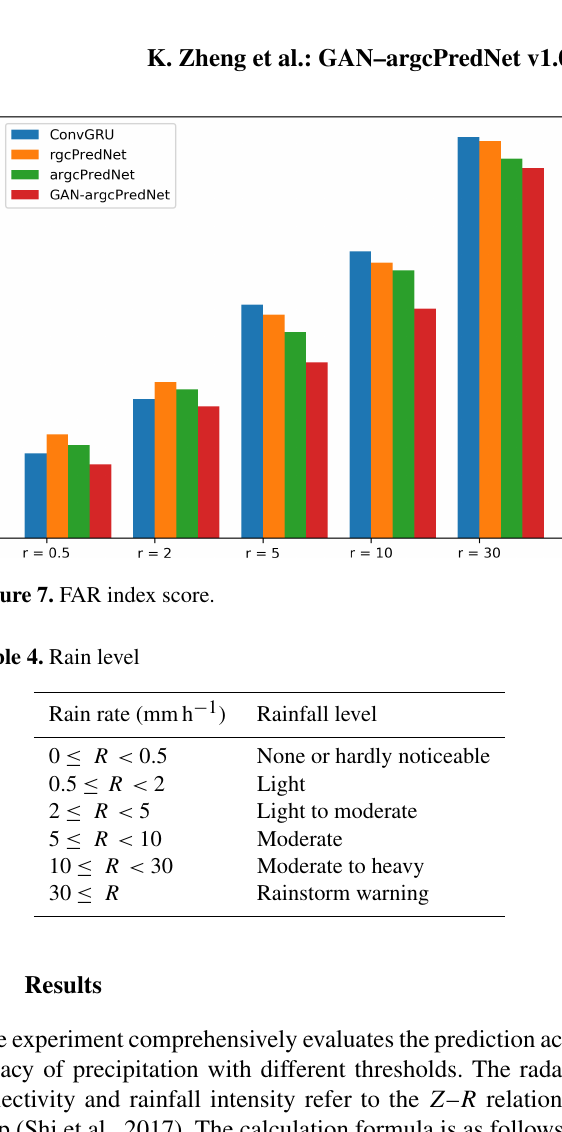
Figure 6. POD index score.